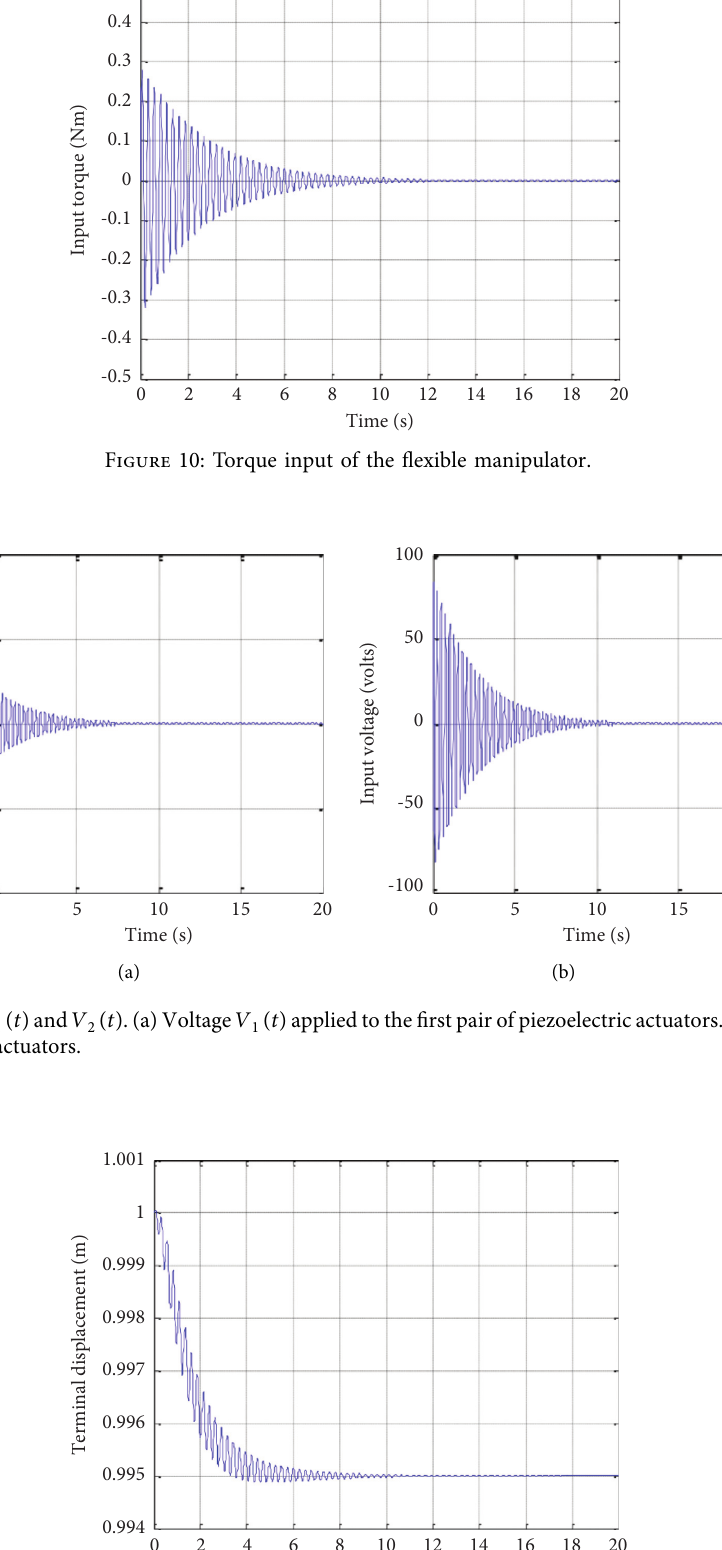
Figure 12: Tip displacement p x with combined PD and PZT